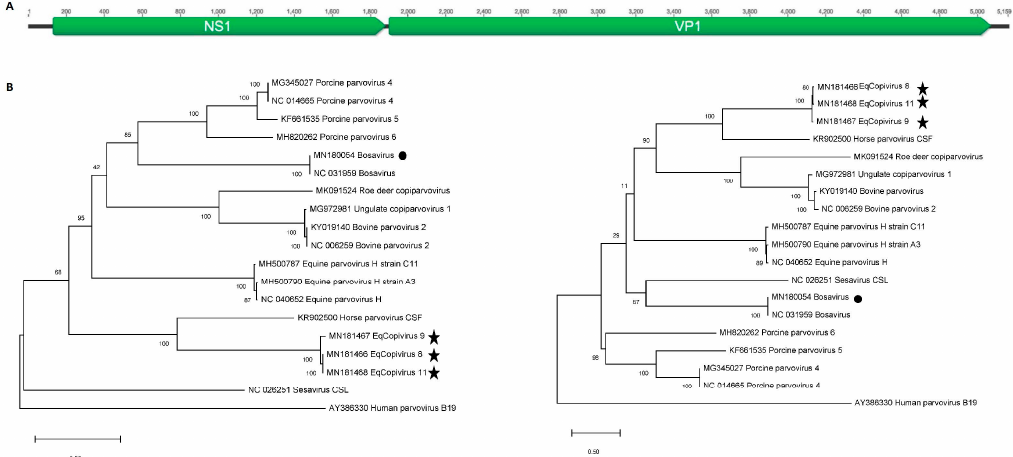
Figure 1. ( A ) Genome ORF (Open Reading Frame) structure of eqcopivirus genome. ( B ) Phylogenetic analysis of NS1 (left) and VP1 (right) proteins in the Copiparvovirus genus. Bootstrap values from a hundred replicate runs are shown. Symbols are used to highlight the new genomes described here.